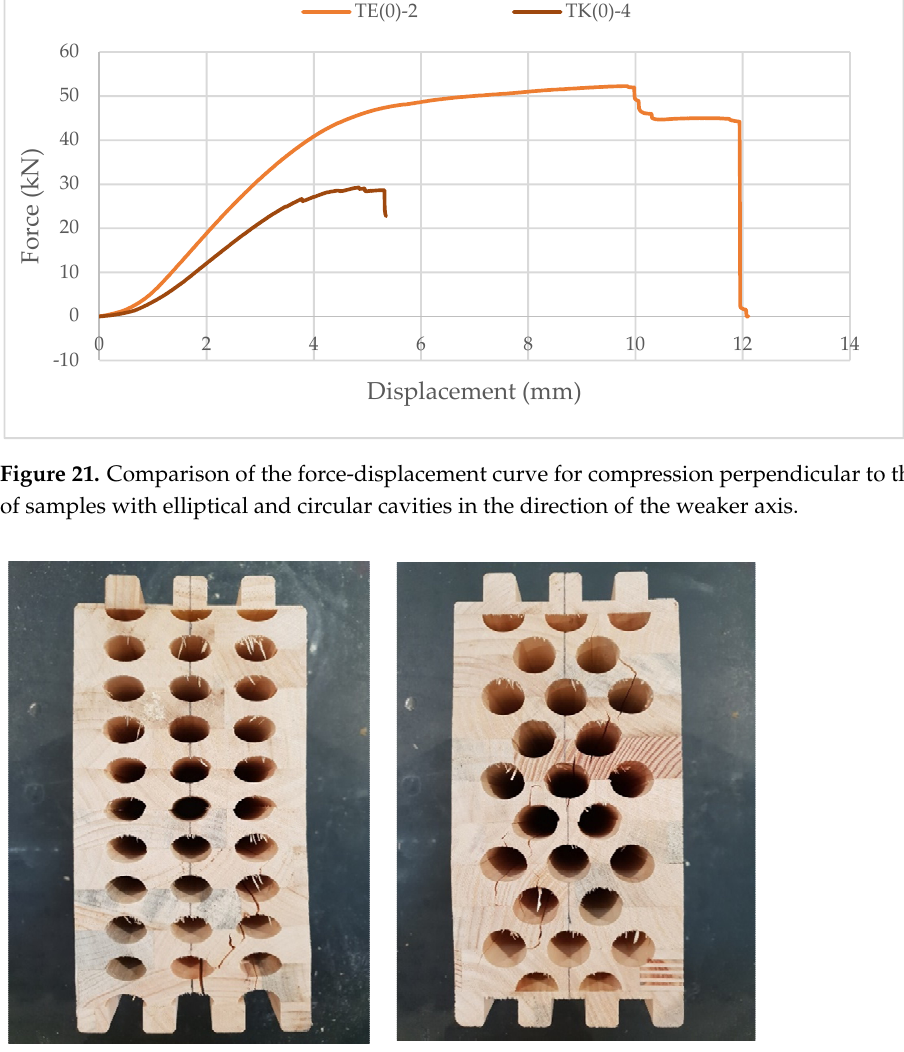
Figure 20. The force-displacement curve for compression perpendicular to the grain of samples with circular cavities in the direction of the weaker axis.